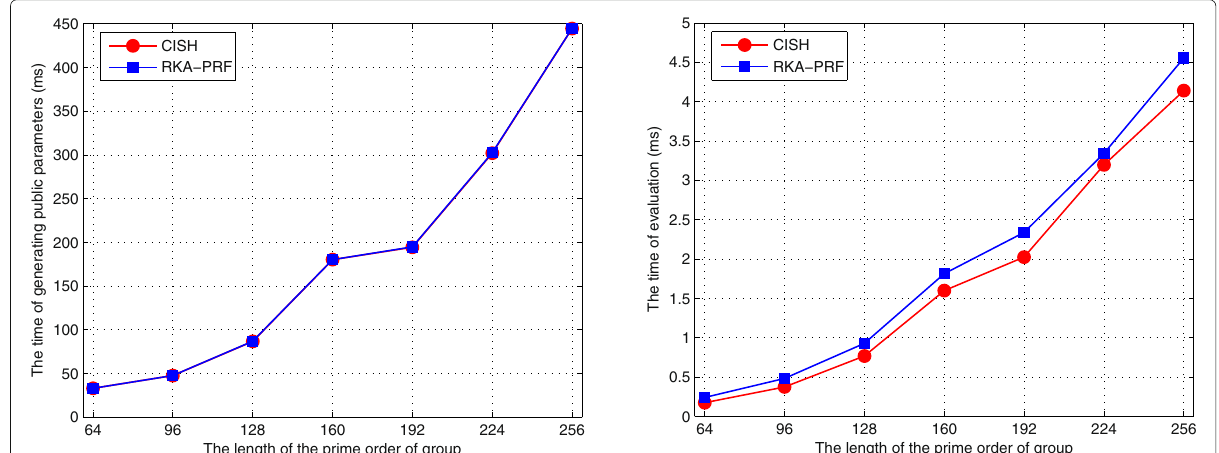
Fig. 3 Z N where N is composite. a The time of generating PP b The time of